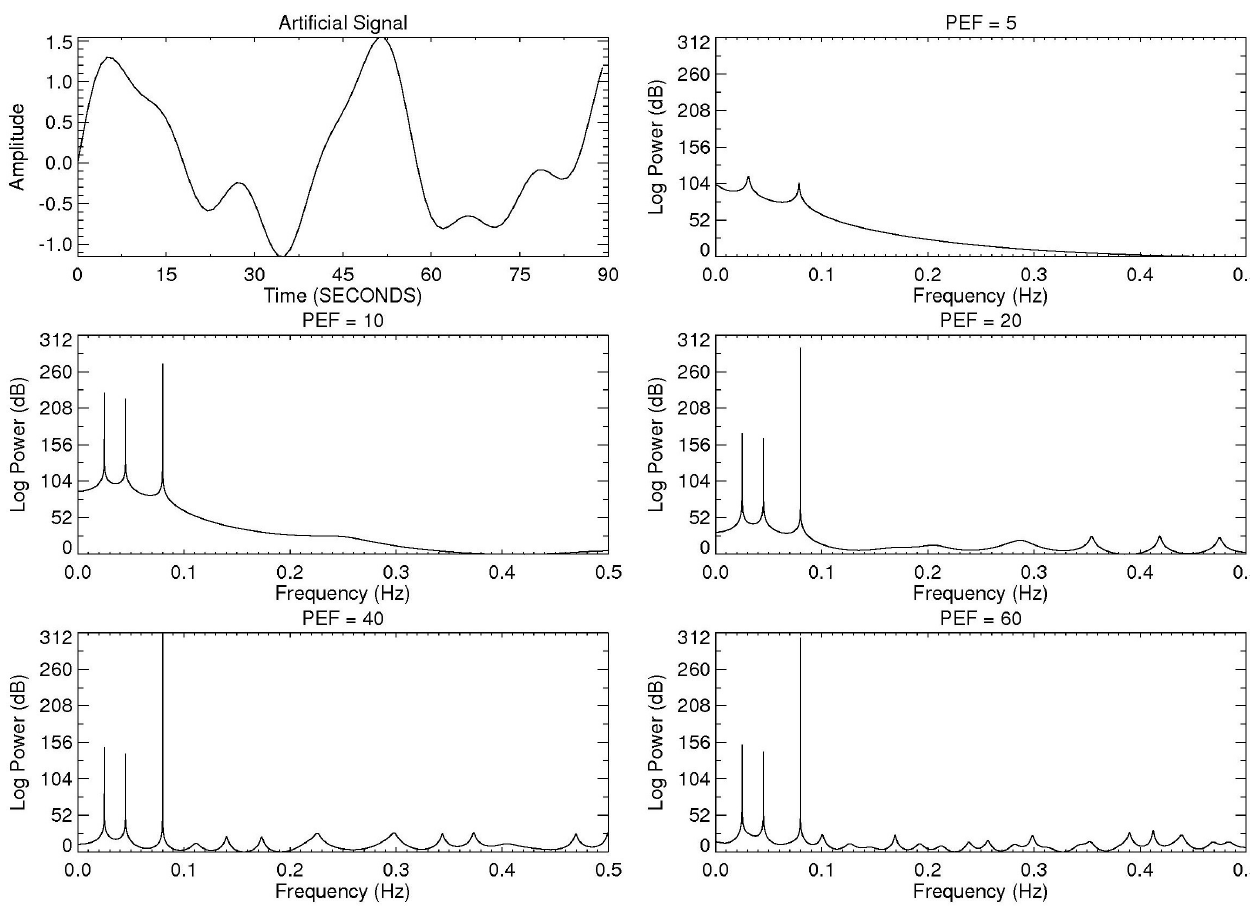
Fig. 1a. MESA spectral estimates of a 90s test signal consisting of three sinusoids without random